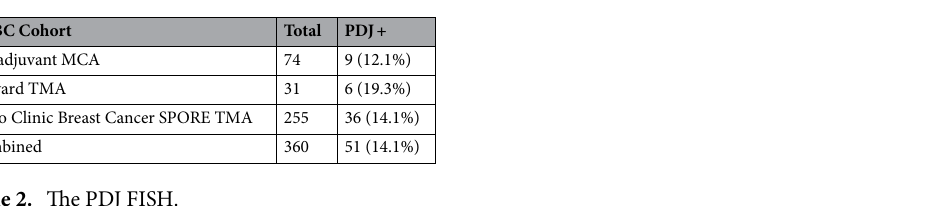
Table 2. The PDJ